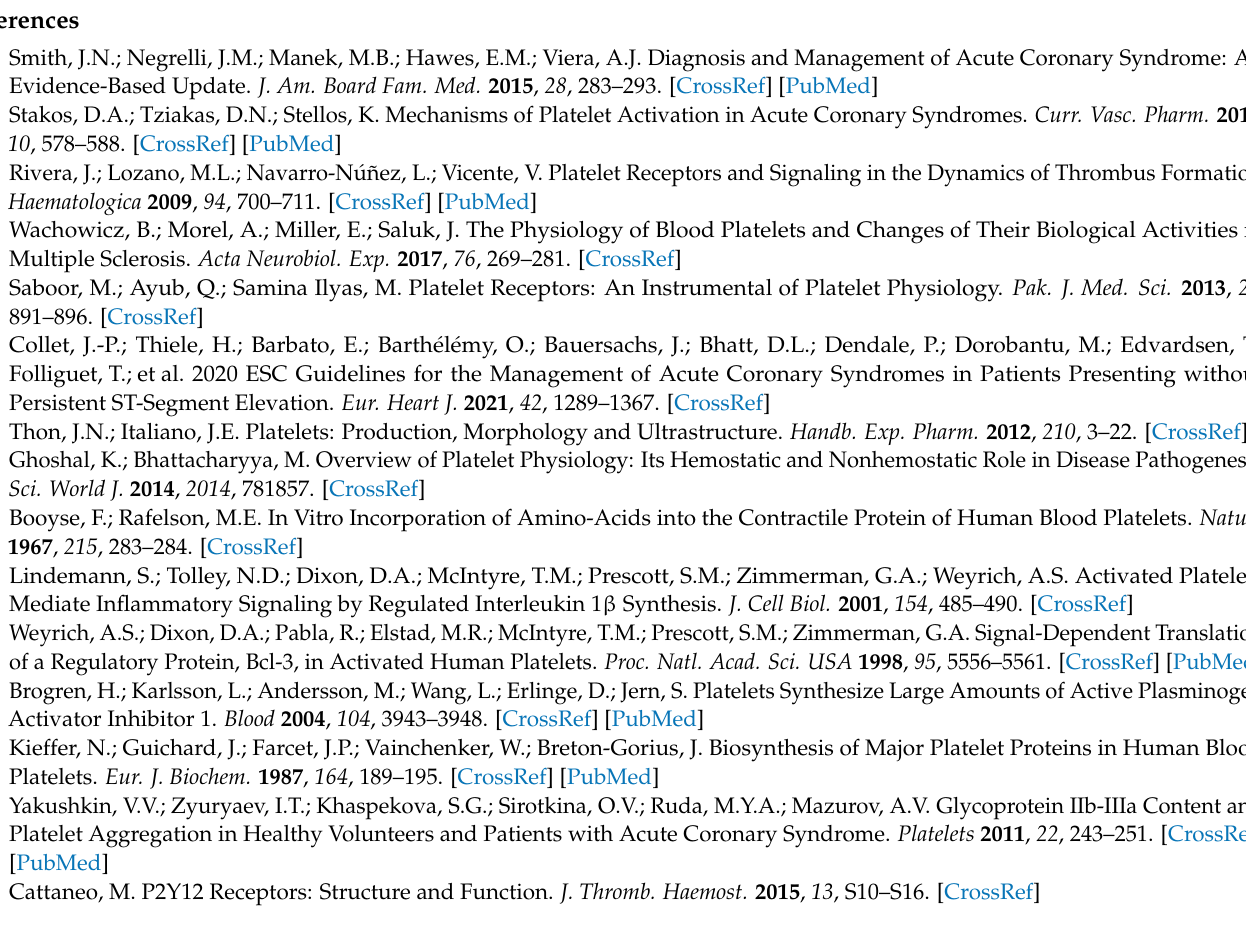
Table S1: Characteristics of the logistic regression model differentiating ACS patients from healthy controls based on miR-223-3p as well as mRNA and protein levels of